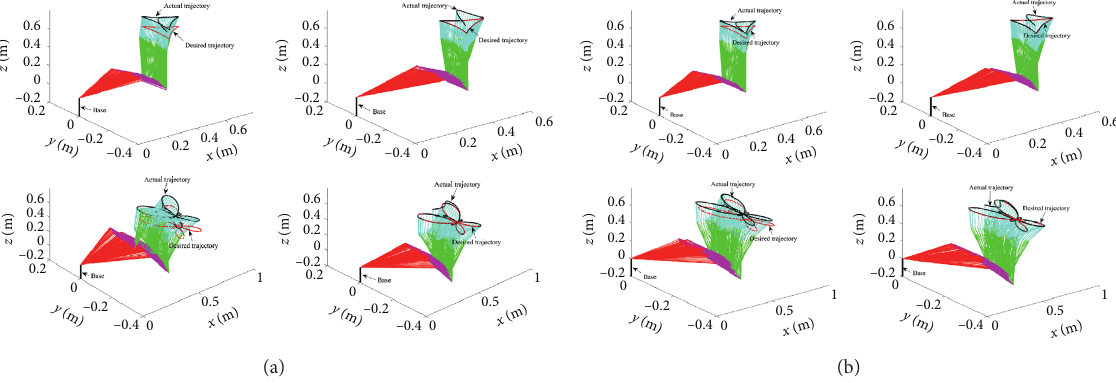
Figure 3: Comparison between schemes equations (22) and (10) under (a) constant-valued noise ω � 1 and (b) time-varying random noise ω � rand ∈ 0 , 1 { } , respectively.